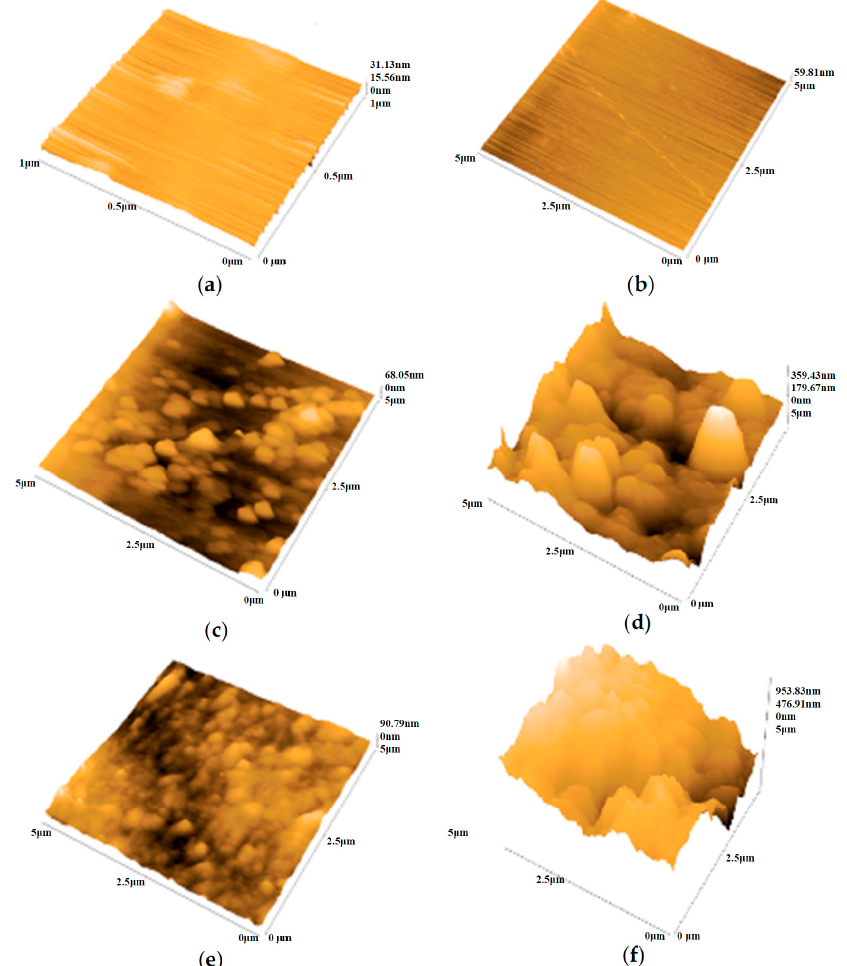
Figure 7. AFM (atomic force microscopy) topography images of Ni-base glassy alloys as-received, at 1.0 M and 12.0 M NaOH solutions at 27 ◦ C: ( a , b ) as-received VZ1 alloy and VZ2 alloy; ( c , d ) VZ1 alloy at 1.0 M and 12.0 M NaOH; ( e , f ) VZ2 alloy at 1.0 M and 12.0 M